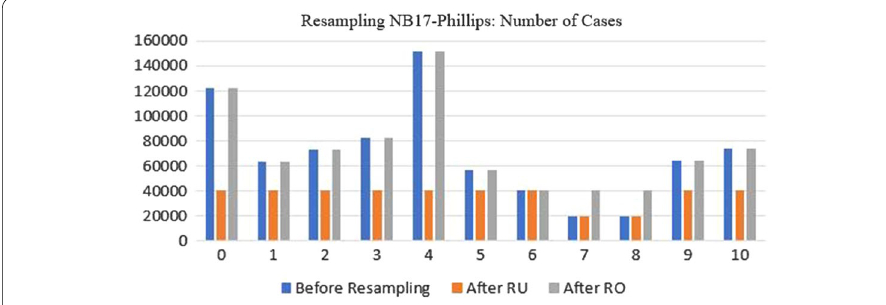
Fig. 16 Resampling of NB17-Philips